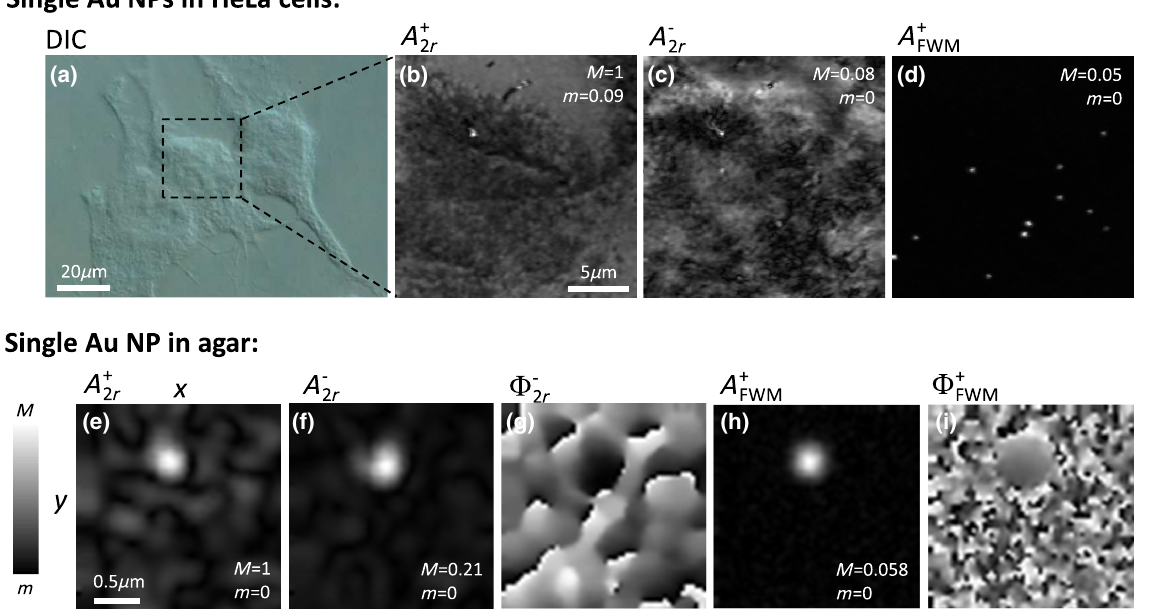
FIG. 3. Background-free FWM detection of single NPs in heterogeneous environments. Top panels: Fixed HeLa cells that have internalized gold NPs of 20 nm radius imaged by (a) differential interference contrast (DIC) microscopy, (b) co-circularly polarized reflection amplitude A þ 2 r , (c) cross-circularly polarized reflection amplitude A − 2 r , and (d) co-circularly polarized FWM amplitude A þ FWM was acquired with a pump-probe delay time of 0.5 ps, pump (probe) power at the sample of 30 μ W ( 15 μ W), 2-ms-pixel dwell time, pixel size in plane of 95 nm and z stacks over 6 μ m in 250-nm z steps. FWM is shown as a maximum intensity projection over the z stack, while the reflection is on a single ð x; y Þ plane (scanning the sample position). Bottom panels: Single ð x; y Þ -plane image of a 25-nm-radius gold NP in 5% agarose gel, via (e) the co-circularly polarized reflection amplitude A þ 2 r , (f) cross-circularly polarized reflection amplitude A − 2 r , and (g) phase Φ − 2 r , (h) co-circularly polarized FWM amplitude A þ with 0.5-ms-pixel dwell time and pixel size in plane of 38 nm. Grey scales are linear from − π to π for all phases and from m to M for field amplitudes, as